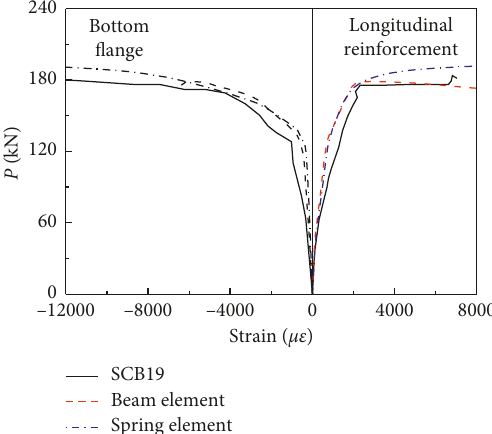
Figure 10: Comparison between the calculated and tested load-end slips of a composite